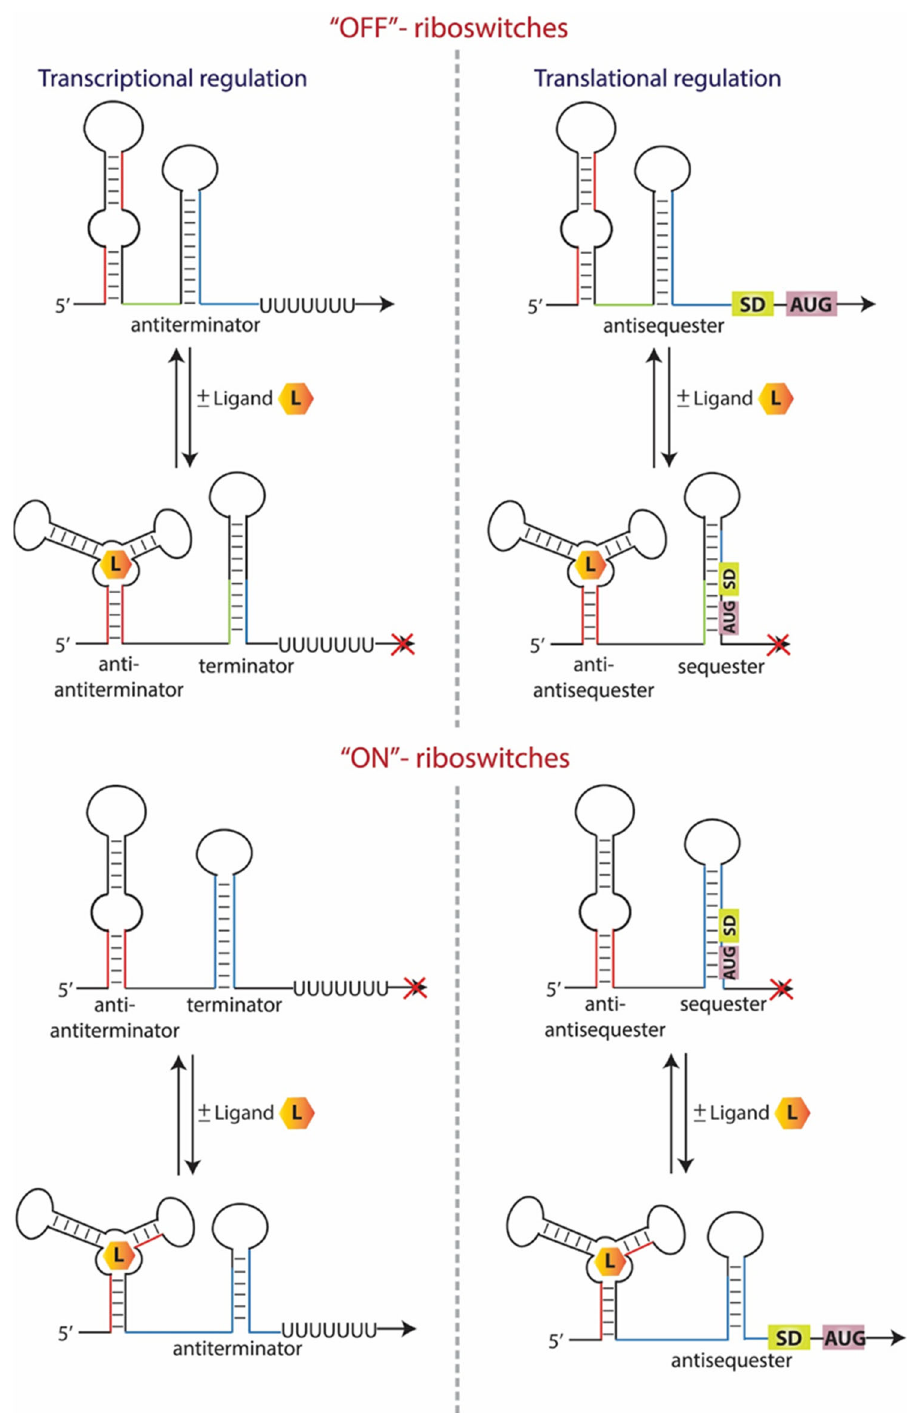
Figure 1. Gene regulation by riboswitches. The binding of the cognate ligands results in termination of transcription ( left ) or translation ( right ) of the downstream genes in the “OFF” riboswitches. In contrast, “ON” riboswitches bind their ligand and modulate their conformation to enable the expression of their downstream genes.